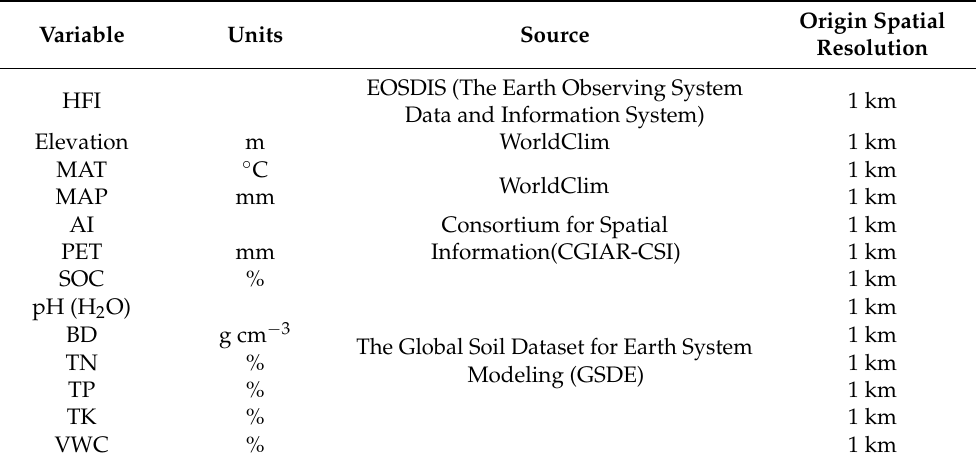
Table 1. Information on the climate and human activity factors derived from 13 global spatial layers detailed in the Section